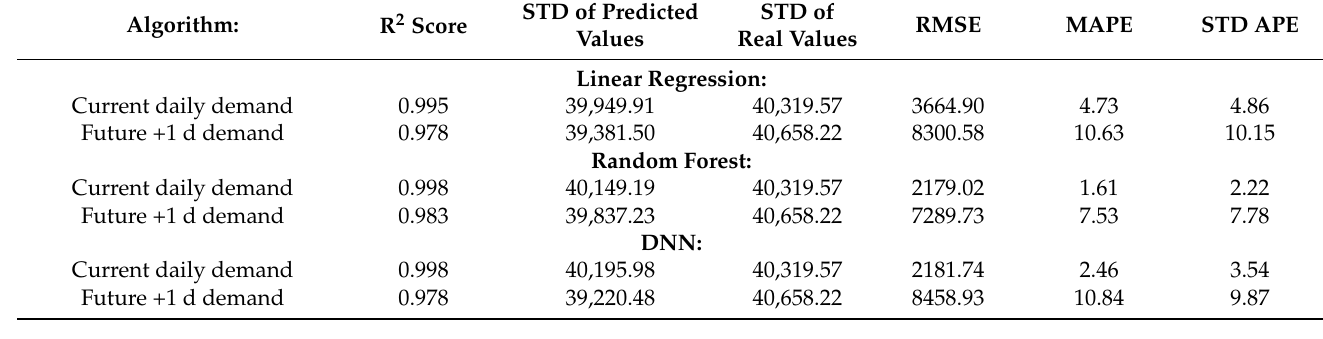
Table 2. Results and comparison the accuracy of prediction depending on used algorithm.